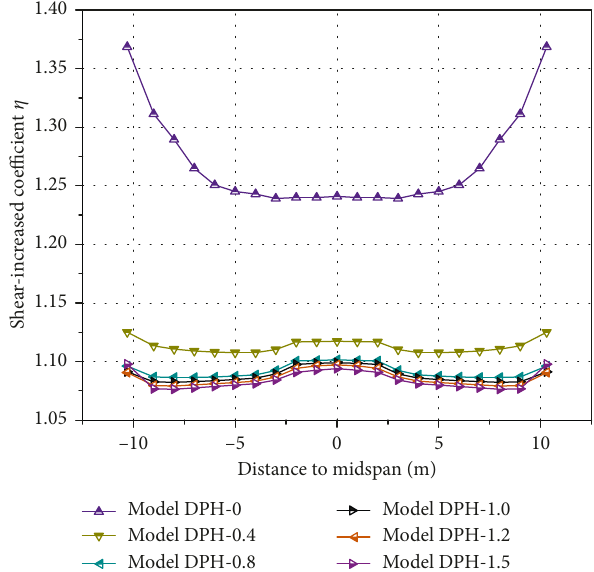
Figure 9: Shear-increased coefficient η with different stiffnesses of end diaphragm cases.